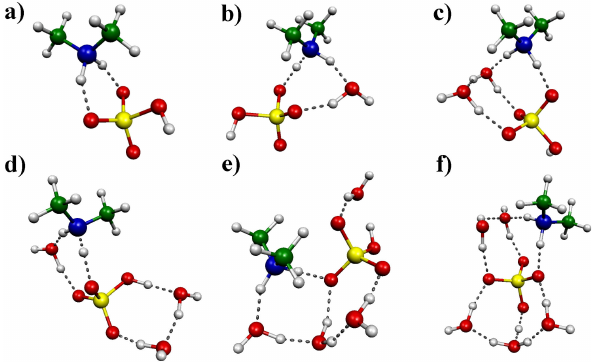
Fig. 3. The most stable structures with respect to the formation free energy 1G (at T = 298 . 15K and P = 1atm) for clusters con- sisting of one sulfuric acid with dimethylamine and 0–5 water molecules: (a) H 2 SO 4 · ( CH 3 ) 2 NH, (b) H 2 SO 4 · ( CH 3 ) 2 NH · H 2 O, (c) H 2 SO 4 · ( CH 3 ) 2 NH · ( H 2 O ) 2 , (d) H 2 SO 4 · ( CH 3 ) 2 NH · ( H 2 O ) 3 , (e) H 2 SO 4 · ( CH 3 ) 2 NH · ( H 2 O ) 4 , (f) H 2 SO 4 · ( CH 3 ) 2 NH · ( H 2 O ) 5